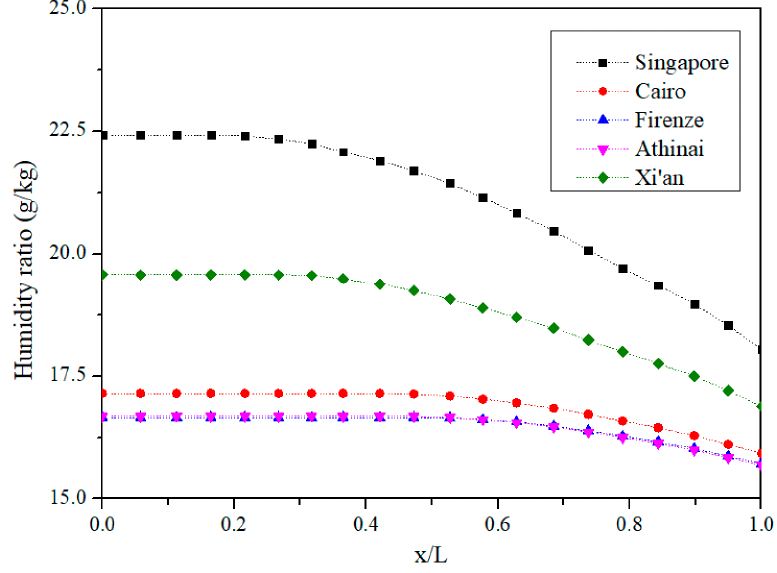
Figure 6. Product air humidity ratio distributions in the pre-cooling IEC.